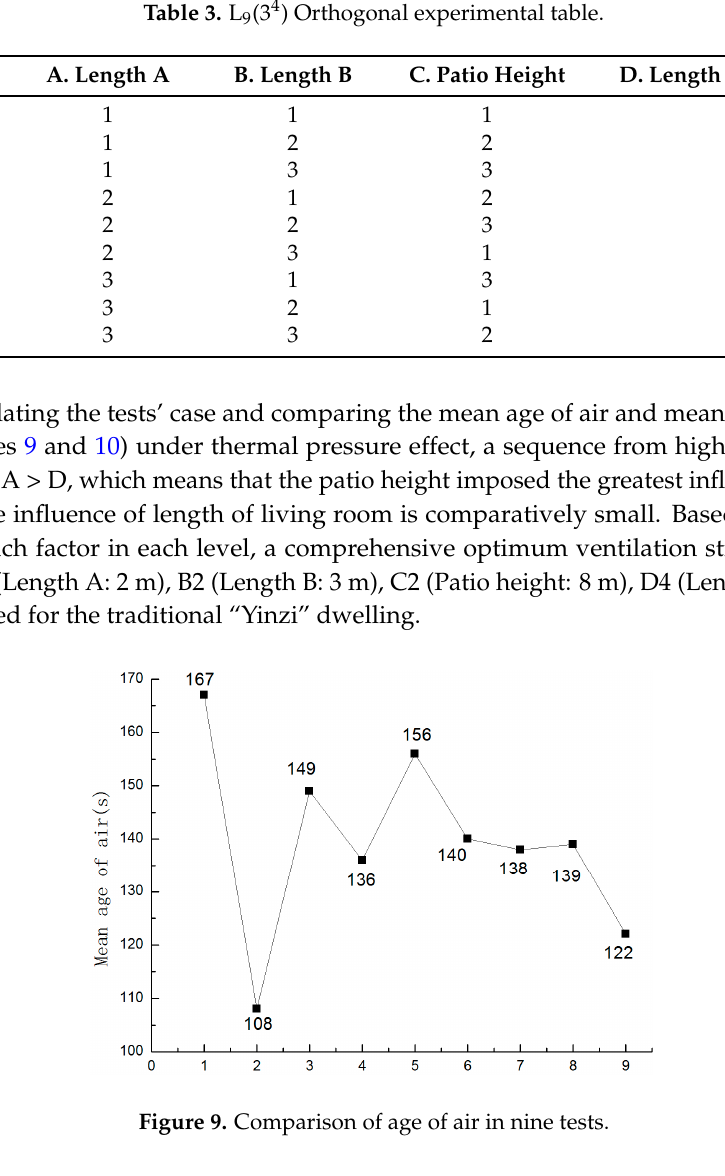
Figure 10. Comparison of wind speed in nine tests.